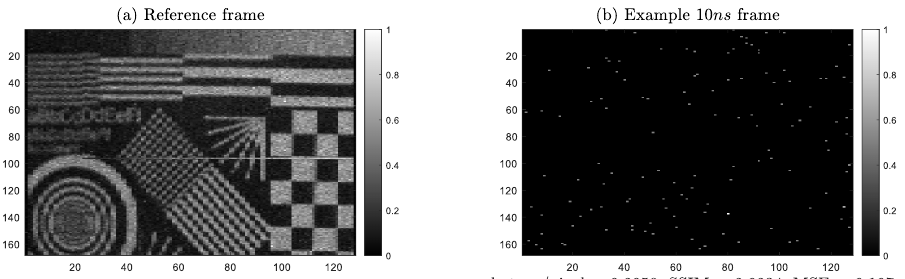
Figure 2. ( a ) Long exposure image ( ≈ 50 µ s) of the test target taken using the SPAD camera in the same setup as used for all of this work. This image is used as the reference for all of the structural similarity and mean squared error calculations performed in this work. ( b ) An example of a 10 ns frame captured in this setup, showing the average number of photons per pixel and the metrics describing the similarities to ( a ). Both of these images have been normalised to their maximum intensity to enable easier